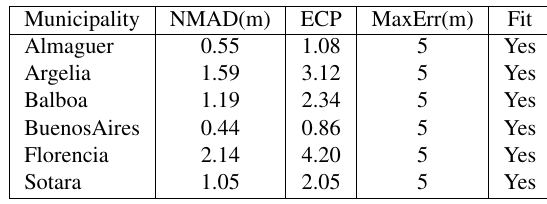
Table 7: Report of the probable circular error (ECP) and the com- parison with tolerance